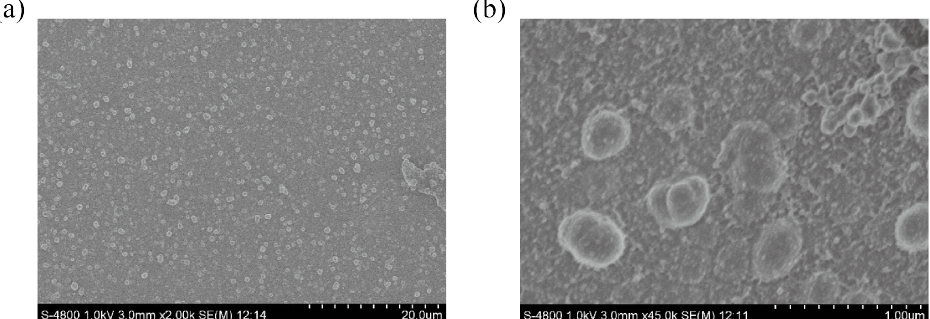
Figure 3. SEM images of Ru-MOFs with magnification of ( a ) 2K and ( b ) 45K.